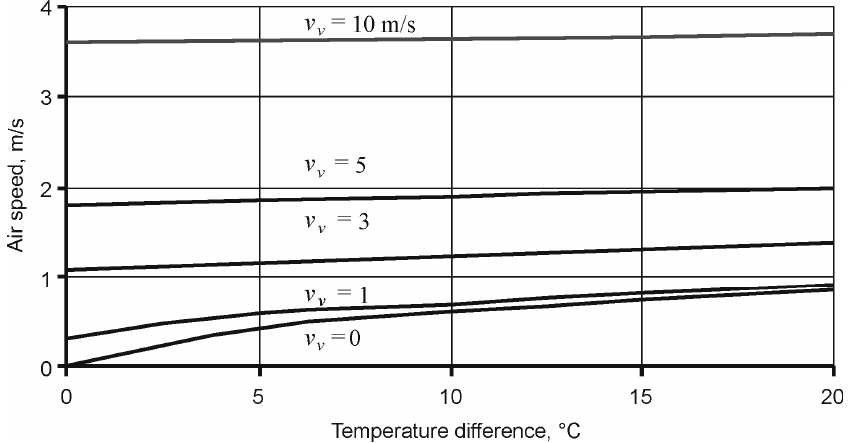
Fig. 2. Analytical dependence of air speed in outlet on indoor-outdoor temperature difference and wind speed v v . Distance between air inlet and outlet openings is H = 4 m, coefficient of discharge of opening is C d2 =